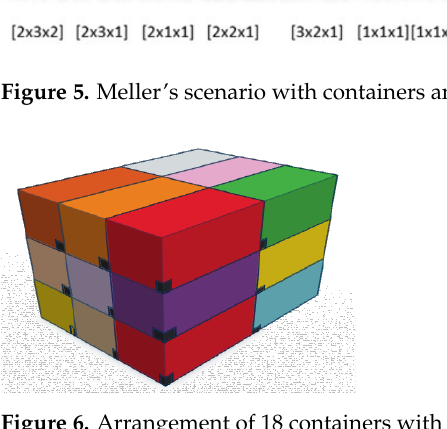
Figure 6. Arrangement of 18 containers with identical